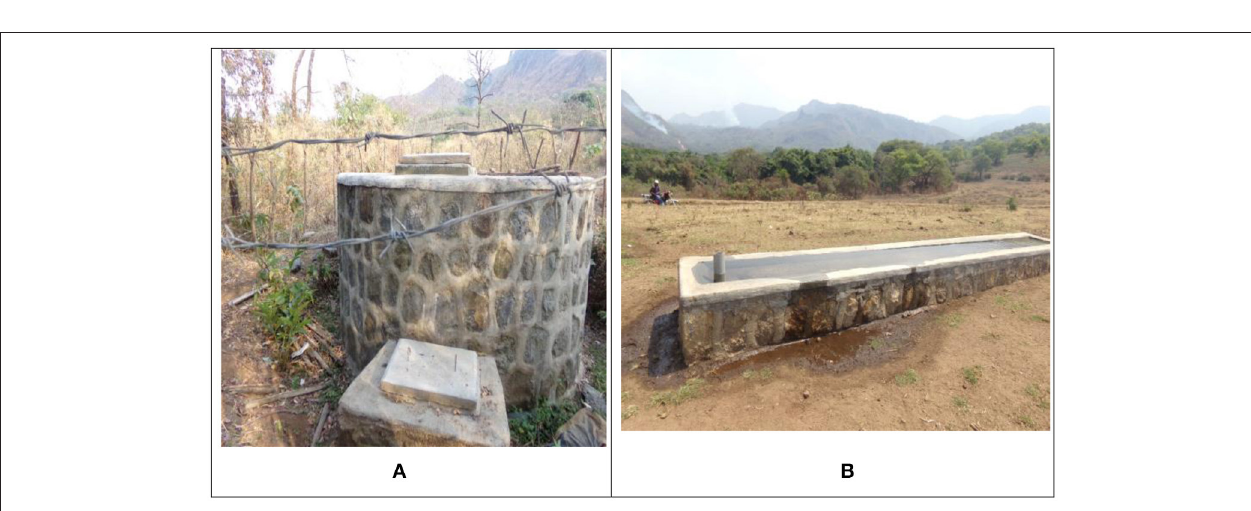
FIGURE 9 | Water supply for livestock production in Achain Ardorat. (A) Water reservoir(tank). (B) Cattle drinking point. Source: Umaru (2018).